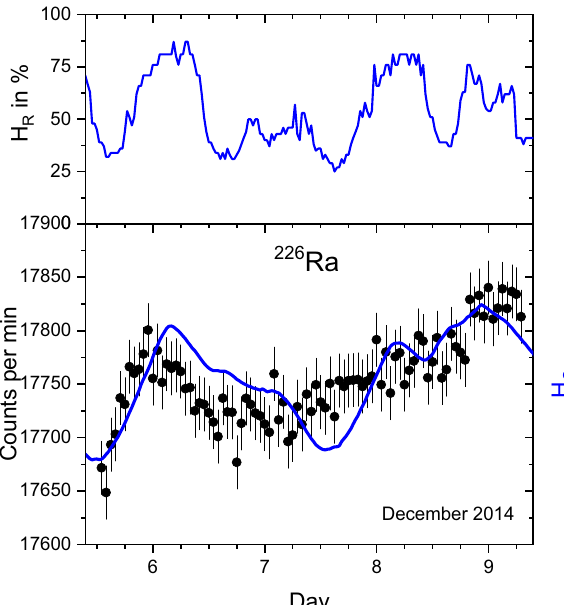
Figure 1. Relative humidity in the Valencia region (top) in the period 5–9 Dec 2014 11 . Qualitative comparison (bottom) of measured 226 Ra decay rates 1–3 with a simple moisture accumulation model 12